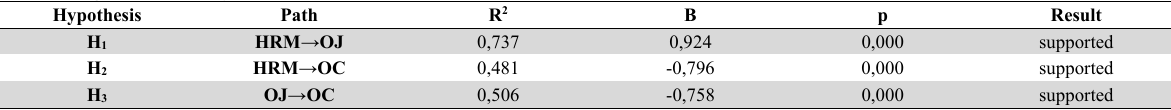
Linear Regression Analysis Results